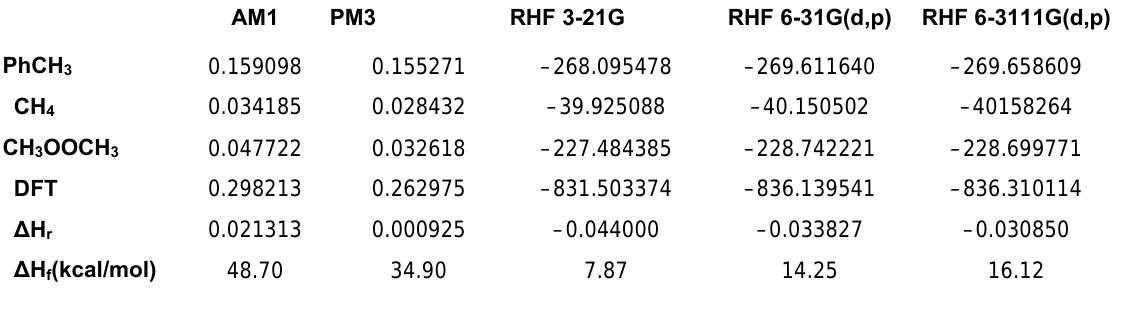
Calculated Energies of Formation (in Hartree Units) and Heat of Reaction (in Hartree